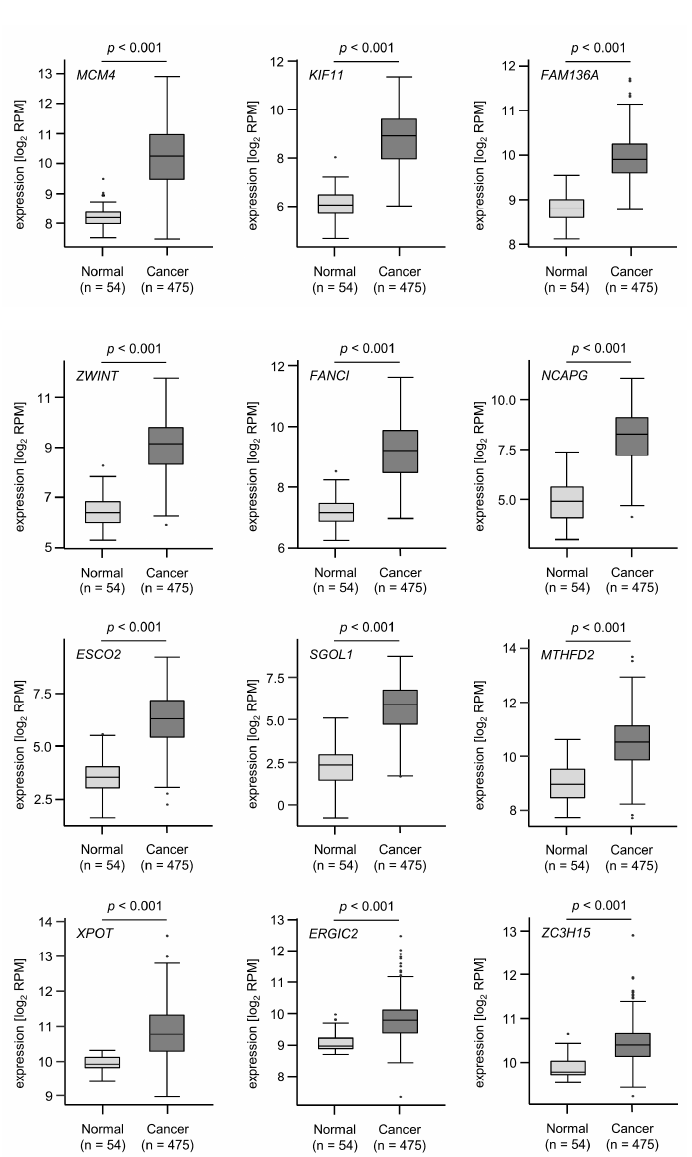
Figure 6. Expression levels of pre- miR-99a target genes in LUAD clinical specimens. Using TCGA datasets, the expression levels of all 22 pre- miR-99a target genes evaluated were upregulated in LUAD clinical specimens ( n = 475) compared with normal lung tissues ( n = 54). The expression data were downloaded from http://firebrowse.org/.